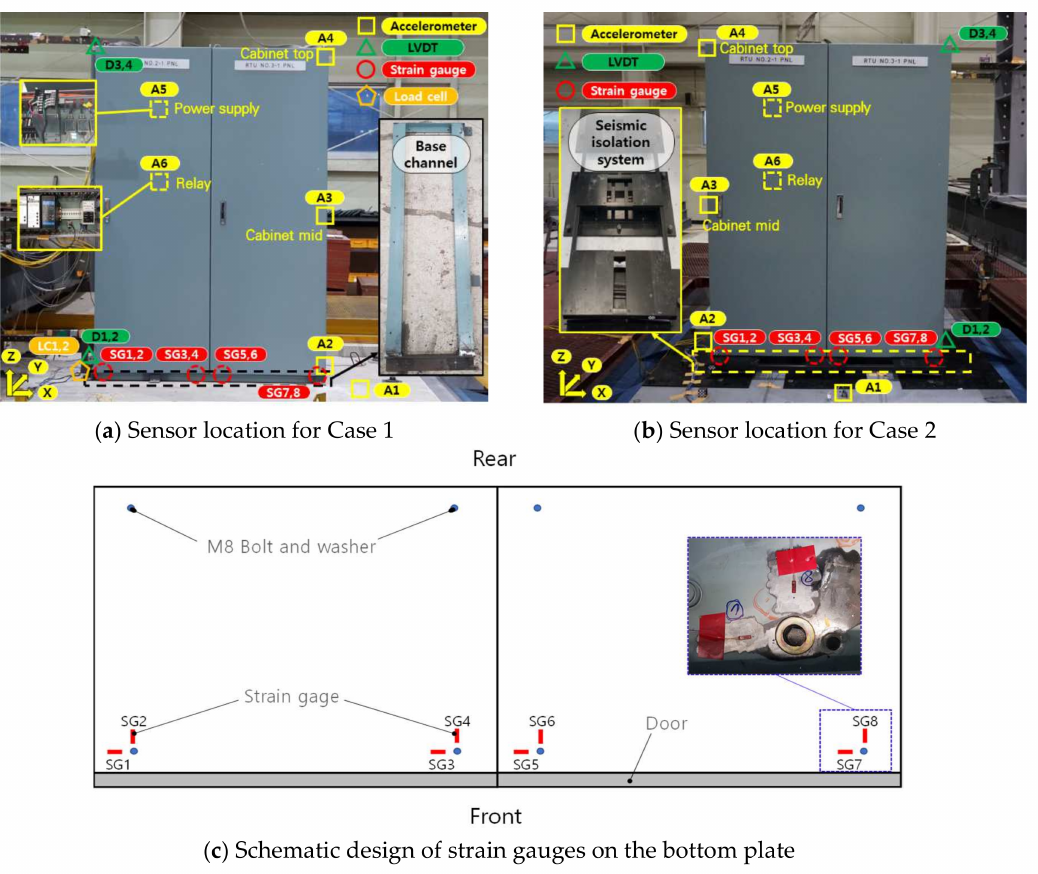
Figure 6. Sensor locations for the cabinet.